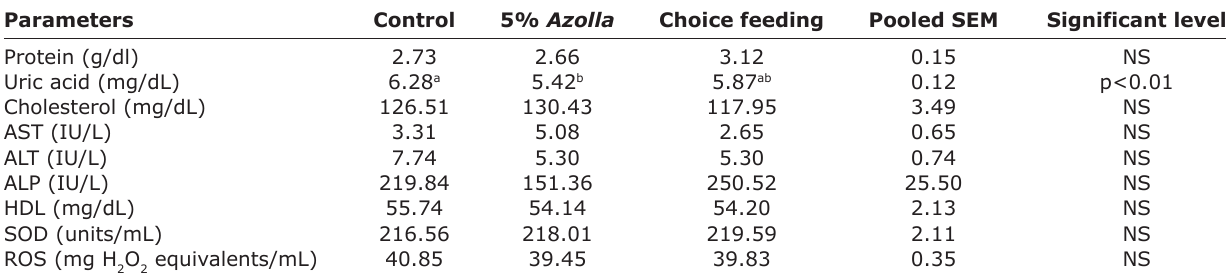
Table-4: Effect of Azolla feeding on blood biochemicals (protein, uric acid, cholesterol, AST, ALT, and ALP) of grower turkeys at 16 weeks of age. Parameters